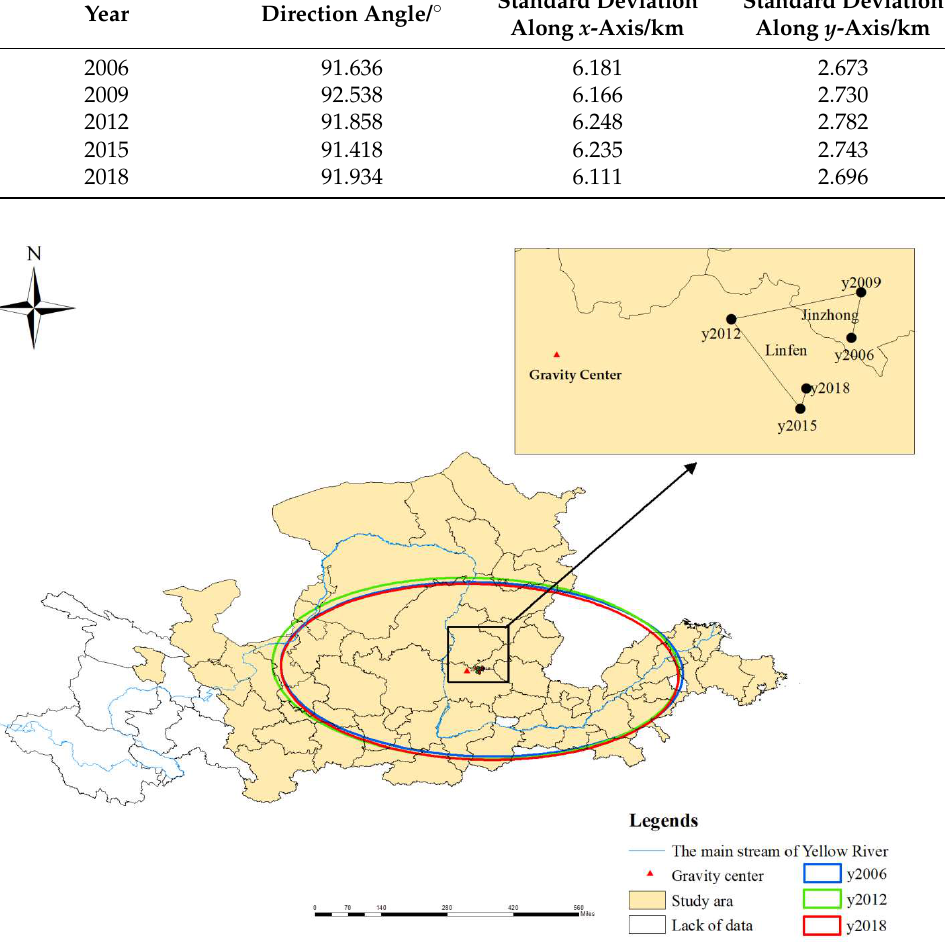
Table 5. Parameters of energy eco-efficiency SDEs in the YRB. Direction Angle/ ◦